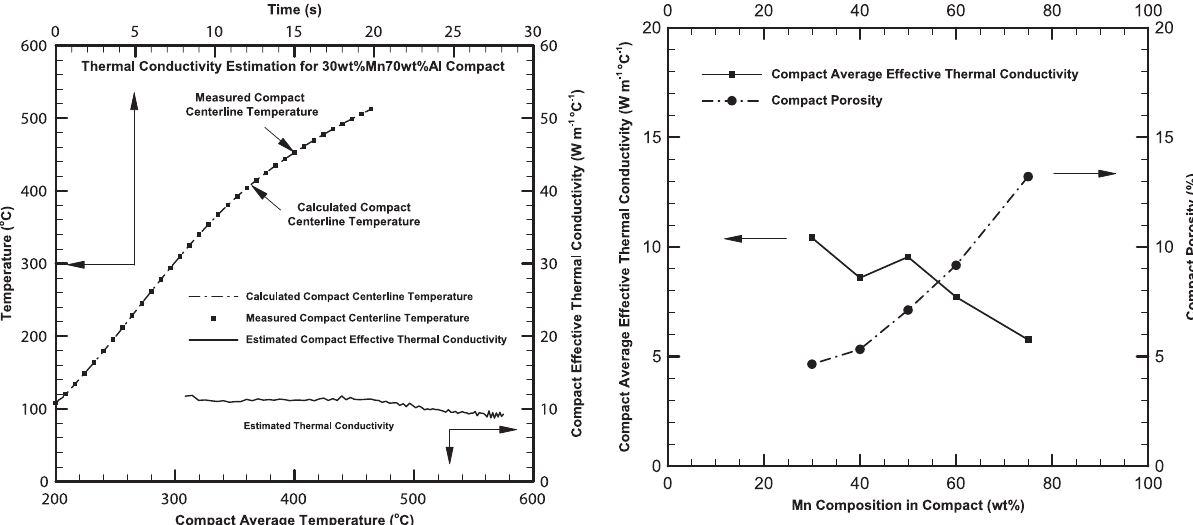
Fig. 17: Effect of Mn composition and porosity in Mn-Al compacts on